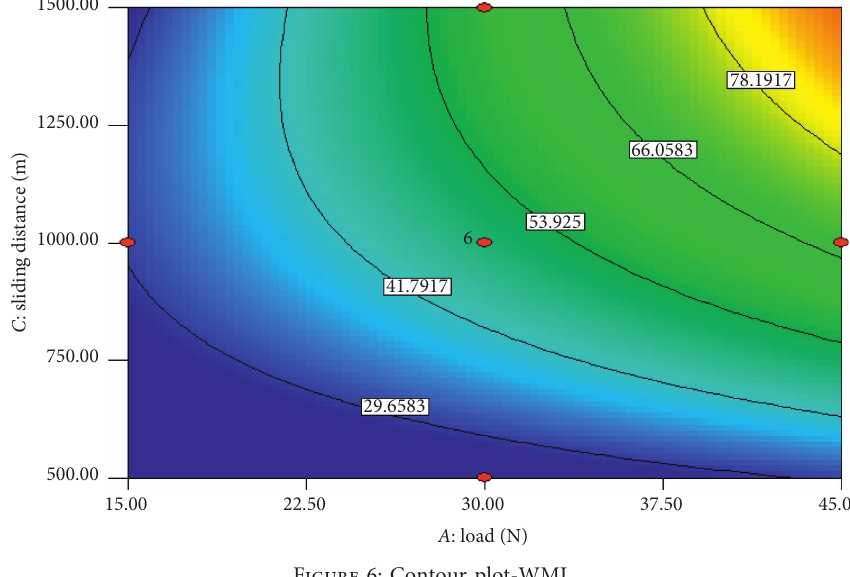
Figure 6: Contour plot-WML.